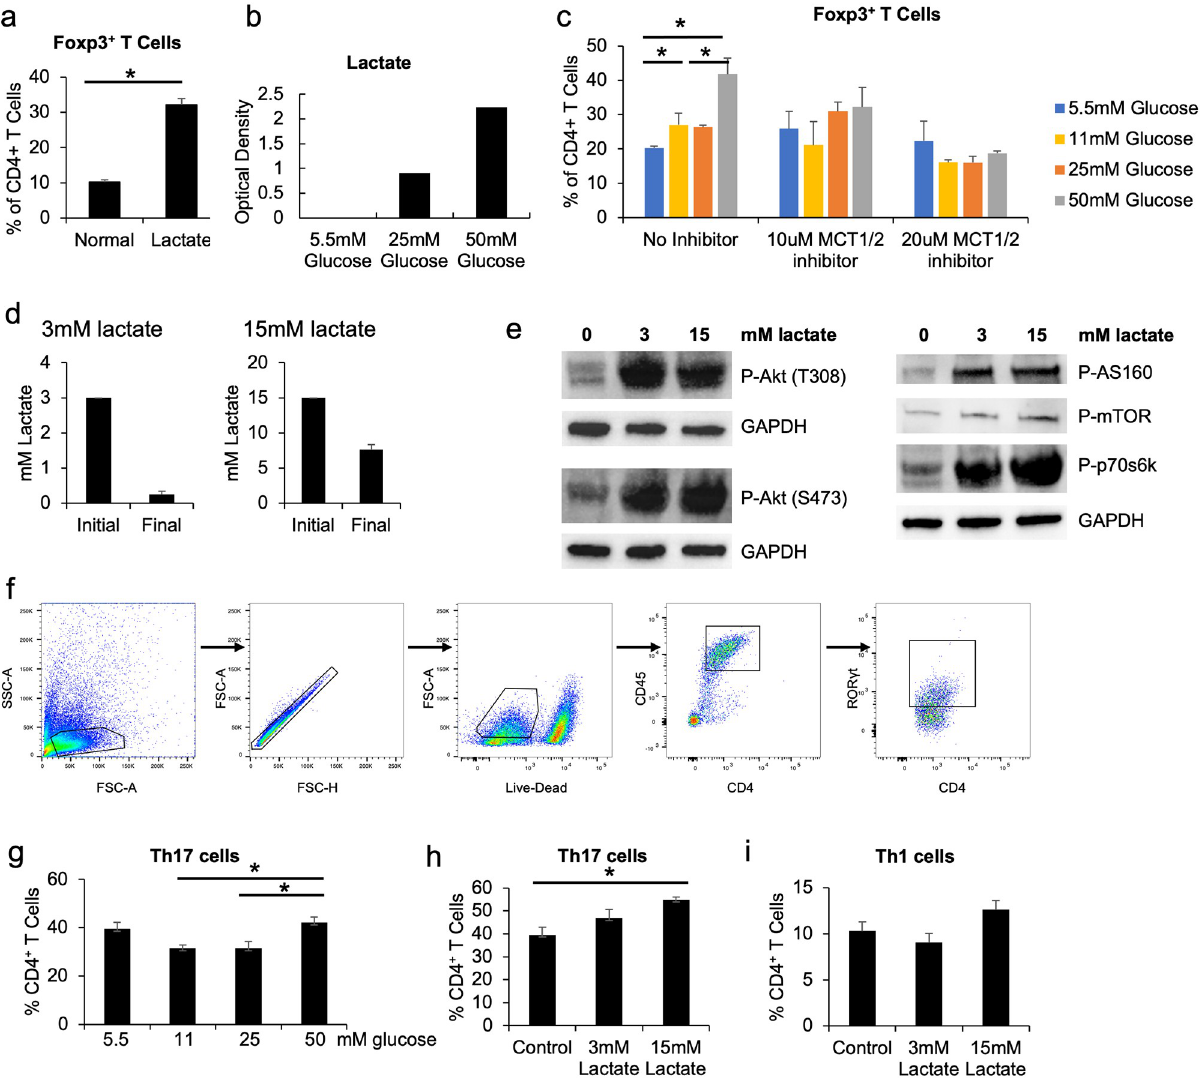
Fig 4. High glucose increases lactate production that promotes iTreg differentiation. a , Na ï ve CD4 + T cells were isolated from C57BL/6 mice and cultured in 96-well plates with plate-bound anti-CD3, soluble anti-CD28 and latent TGF- β , with or without lactate for 72 hours. Cells were then analyzed by flow cytometry for the percentage of Tregs (Foxp3 + ). b , Na ï ve CD4 + T cells were isolated from C57BL/6 mice and cultured in 96-well plates with plate-bound anti-CD3, soluble anti-CD28 and latent TGF- β for 24 hours. Culture supernatants were collected from each well, deproteinized, and assayed for total lactate level using a plate reader. Result represents pooled culture supernatants of 3 biological repeats. c , Na ï ve CD4 + T cells were cultured in 96-well plates with plate-bound anti-CD3, soluble anti-CD28, and latent TGF- β , with or without MCT1/2 inhibitor for 72 hours. Cells were then analyzed by flow cytometry for the percentage of Tregs (Foxp3 + ). N = 3, and data are presented means ± S.E.M. � p < 0.05 by Student’s t test. d , Tregs were differentiated from na ï ve T cells for 3 days. Cells were then cultured in 3 (left panel) or 15 (right panel) mM lactate for 24 hours, and the concentration of the remaining lactate in the culture medium was measured by the lactate assay. e , Differentiated Tregs were cultured in 3 or 15 mM lactate for 24 hours, and whole cell extracts from these cells were analyzed by Western blotting for indicated markers. f – h , Na ï ve CD4 + T cells were cultured in 96-well plates with plate-bound anti-CD3, soluble anti-CD28, active TGF- β , and IL-6 for 3 days, under indicated glucose ( g ) or lactate ( h ) levels, and analyzed for Th17 differentiation. Representative gating strategy for Th17 flow cytometry are shown in f . i , Na ï ve CD4 + T cells were cultured in 96-well plates with plate-bound anti-CD3, soluble anti-CD28 and anti-IL-4, IL-2, and IL-12 for 3 days, under indicated lactate levels, and analyzed for Th1 differentiation. RPMI medium containing 5.5 mM glucose and 10% FBS was used as controls for lactate stimulation.